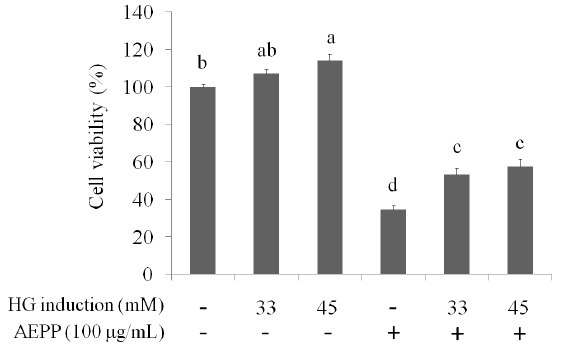
Figure 2. The suppression of AEPP on OVCAR-3 ovarian carcinoma cells induced by high glucose (HG). Data were shown as mean ± SD ( n = 3). Different letters indicate a significant difference between groups ( p < 0.05).